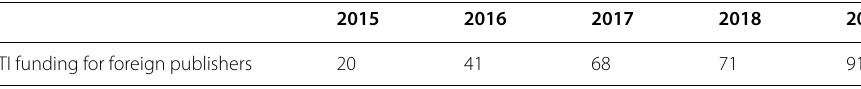
Source : Literature Translation Institute of Korea